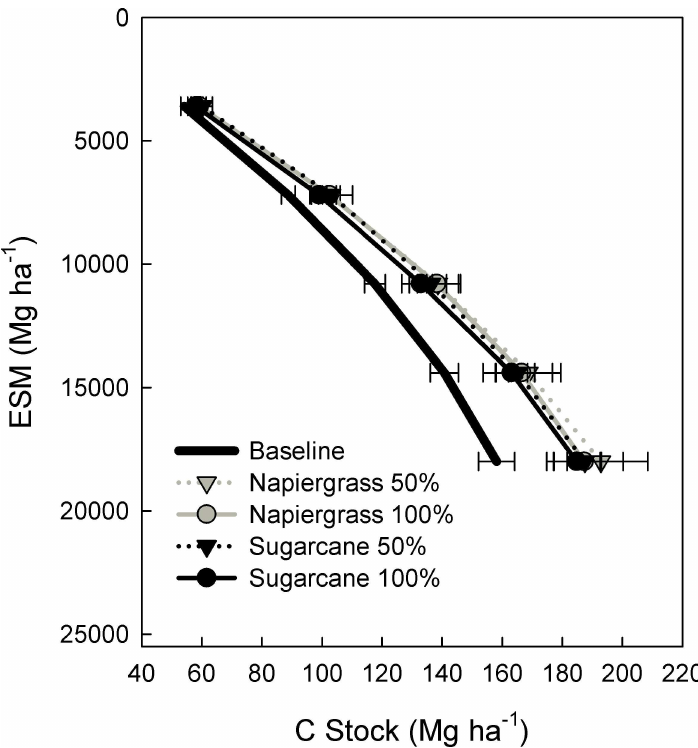
Fig 5. Two yearsof soil carbon accumulation. Soil C stock at baselineversus year 2 for sugarcane and napiergrass at 100% and 50% of the plantationirrigationlevel. Valuesare means ( ± one standard error); n = 10 for the baselinesoils, n = 3 for the trial